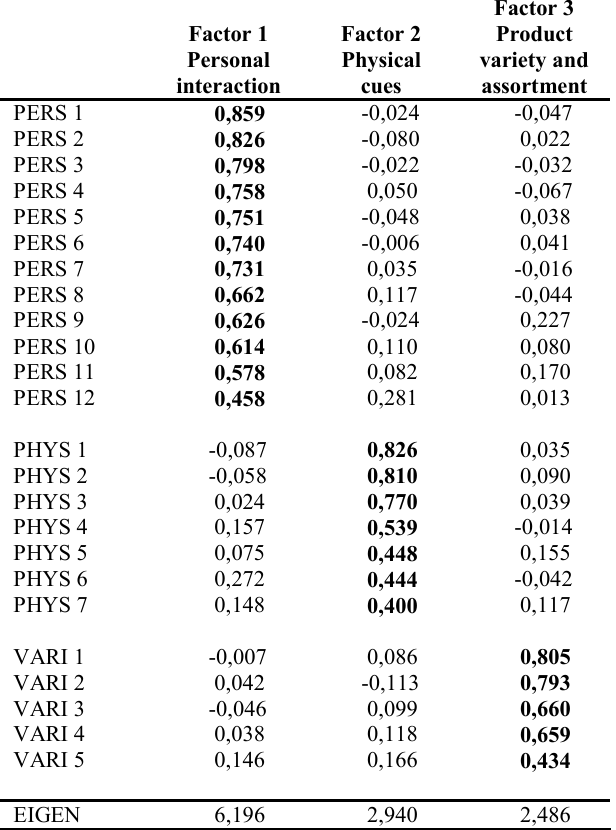
Table 1: Sorted rotated factor loadings